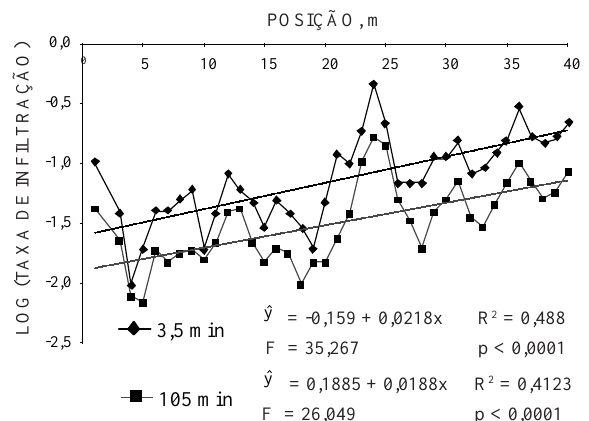
Figura 3. Logaritmo da taxa de infiltração (m h -1 ) versus posição na transeção, com as respectivas retas ajustadas. Os valores dos coeficientes de regressão e o teste F foram usados para verificar a significância do